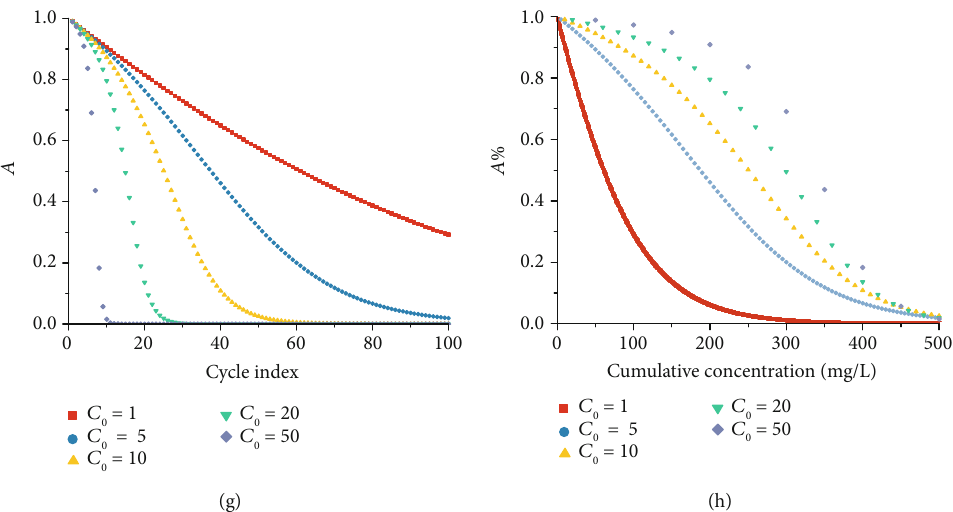
Figure 11: Cyclic adsorption curves. (a) Pb(II), f = 15 . (b) Pb(II), f = 15 . (c) Cd(II), f = 15 . (d) Cd(II), f = 15 . (e) Cr(III), f = 15 . (f) Cr(III), f = 15 . (g) Mn(II), f = 15 . (h) Mn(II), f = 15